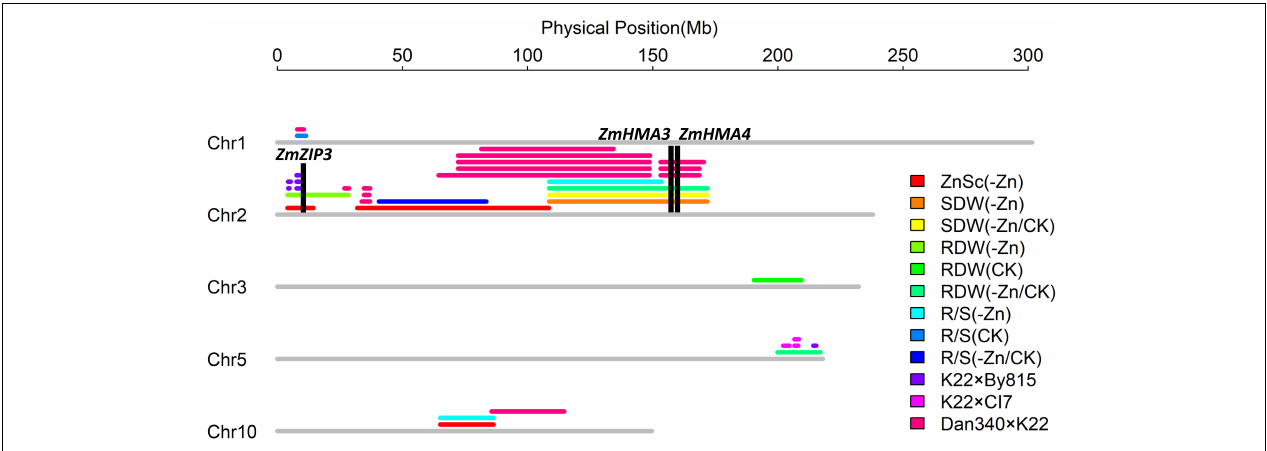
FIGURE 7 | Thirteen loci detected on chromosomes 1, 2, 3, 5, 10 in the Ye478 × Wu312 RIL population and the co-localizations (unpublished data of our lab) identified in the K22 × By815, K22 × CI7, and Dan340 × K22 RIL populations. Important candidate genes ( ZmZIP3 , ZmHMA3 , ZmHMA4 ) are depicted in black